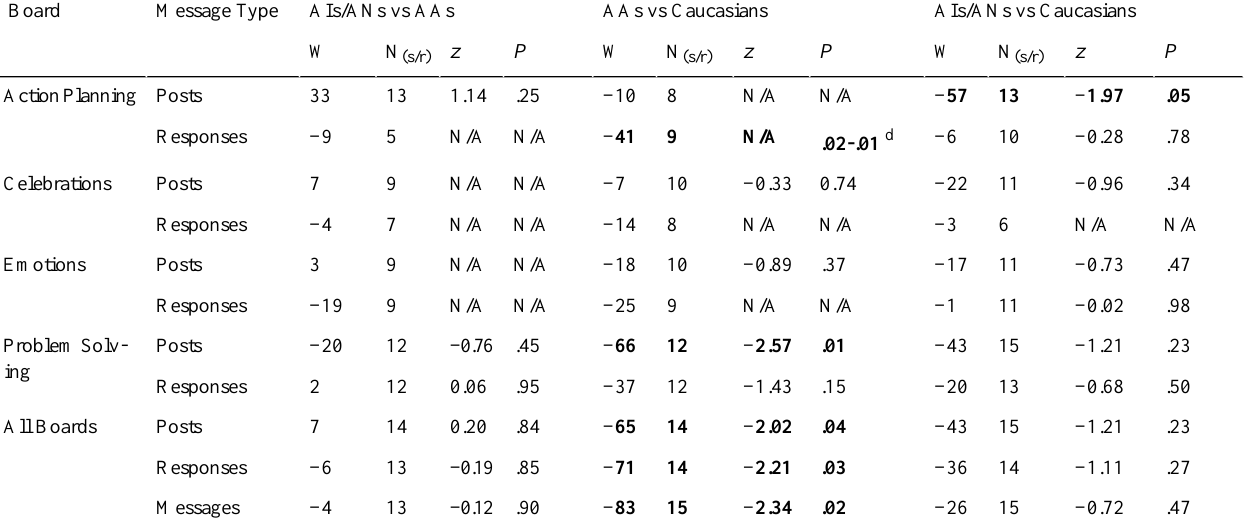
AIs/ANs vs CaucasiansAAs vs CaucasiansAIs/ANs vs AAsMessage Type